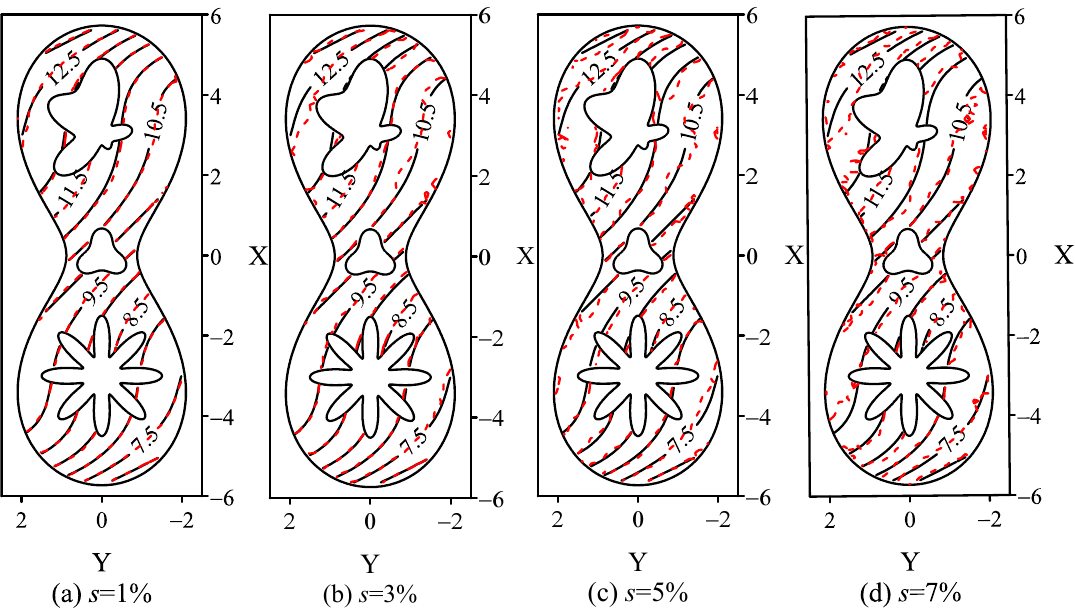
Figure 10. The comparison of numerical (dashed curves) and analytical solutions (solid curves).